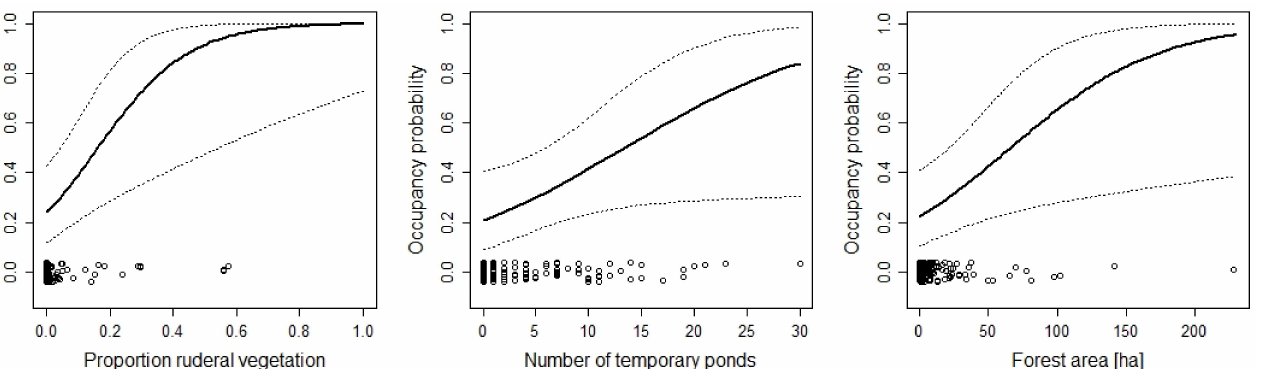
Figure 2. The effects of the proportion of the area within a site covered with wetland vegetation and ruderal vegetation within a site on the occupancy probability of Alytes obstetricans . The dotted lines show the 95% confidence interval. Circles indicate observed values of the explanatory variable. Other explanatory variables in the model were fixed either at their median or the mean values, depending on the skewness of the distribution. The relationship is for sites where the species was known to occur in the past (i.e., the occupancy probability can be interpreted as a persistence probability).